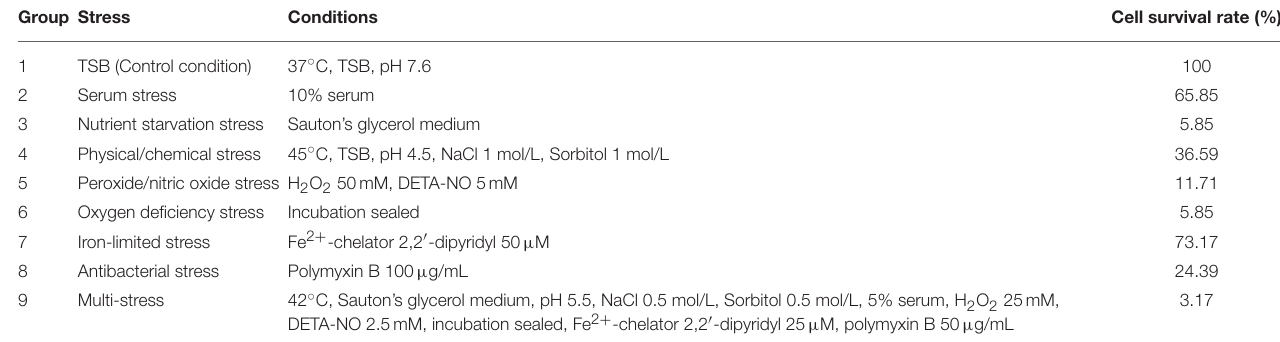
TABLE 1 | Survival of B. abortus under environmental